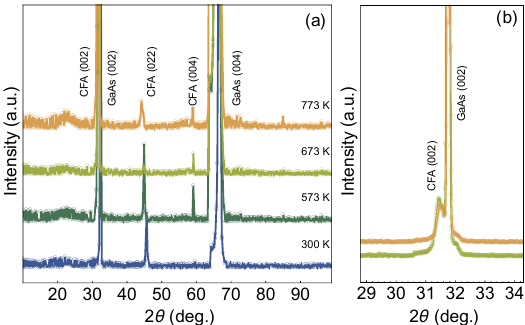
Figure 2. ( a ) High-angle x-ray diffraction results for the Co 2 FeAl/W bilayers grown onto GaAs (100) substrate. ( b ) Detailed view of the curves, in which the CFA(002) peak can be visualized. The CFA pattern is obtained from ICDD 01-0715670. Notice the polycrystalline character of the CFA alloy in all samples of the